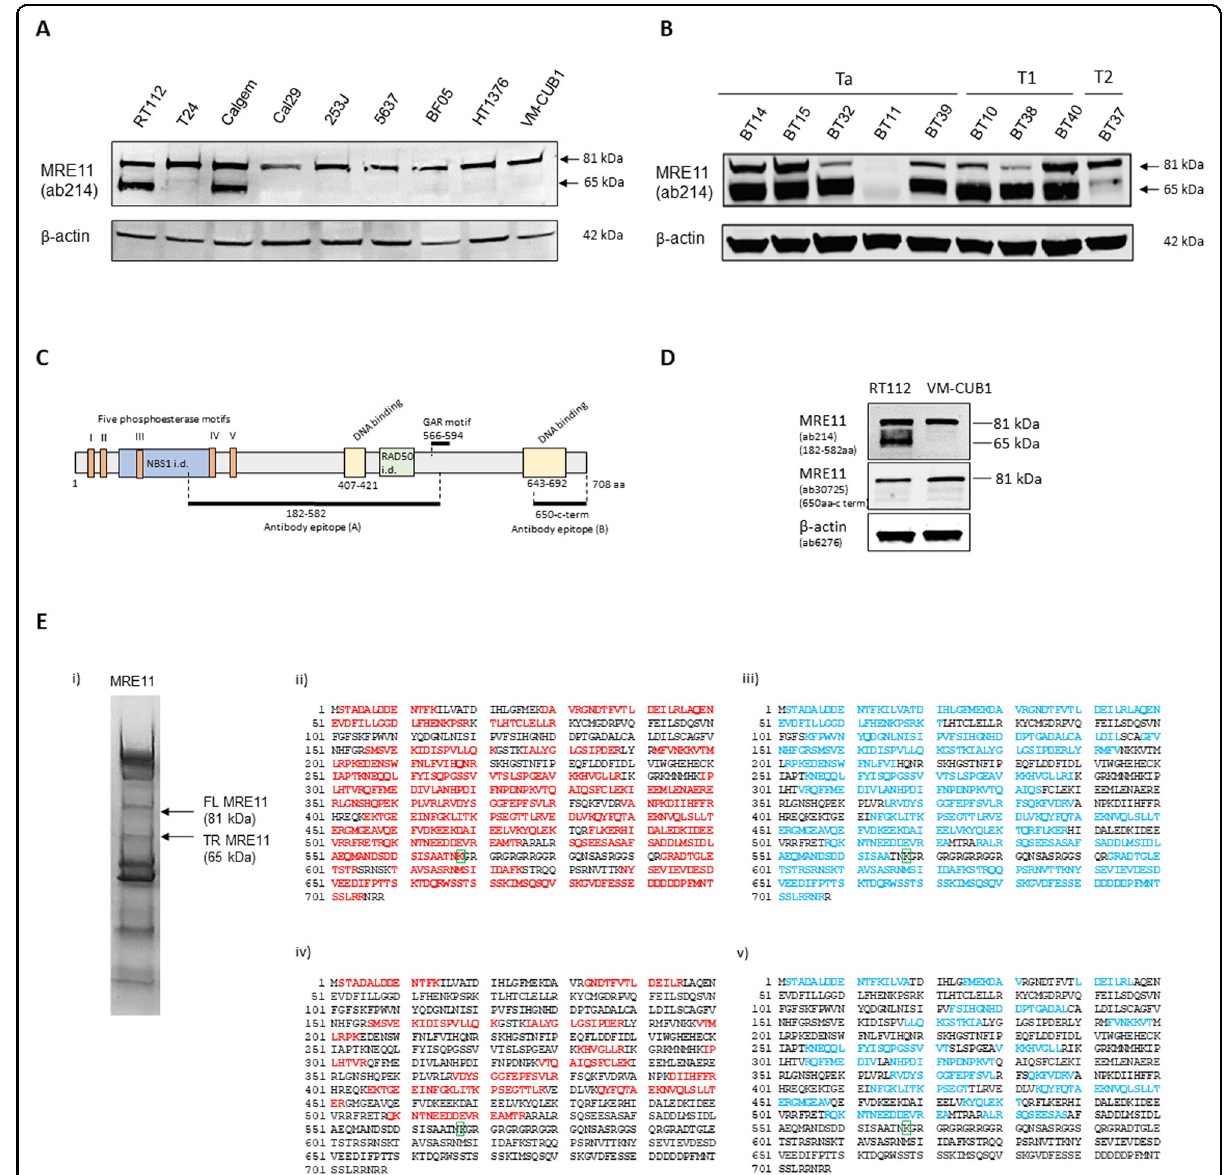
Fig. 1 MRE11 is found in truncated form in bladder cancer cell lines and primary bladder tumours. A Two out of nine bladder cancer cell lines show a truncated form of MRE11 (approximately 65 kDa). Calgem is gemcitabine-resistant cells created from Cal29 by exposure to increasing gemcitabine doses 49 . B Eight out of nine nuclear cell-free extracts from human bladder tumours show a truncated form of MRE11 (approximately 65 kDa). Ta = papillary tumour, T1 = tumour invading lamina propria, T2 = tumour invading muscularis propria. C Schematic diagram of MRE11 and the epitope regions of MRE11 of two antibodies, spanning amino from acids 182 to 582 (ab214) and 650 to C-terminus (ab30725), respectively. D In RT112, ab214, spanning amino acids 182 – 582, detected both FL and TR MRE11, but not in VM-CUB1. In contrast, the C-terminus anti-MRE11 antibody (ab30725) did not detect the truncated MRE11 both in RT112 and VM-CUB1. E -i The eluted sample from super-paramagnetic beads with recombinant protein A-bound MRE11 was loaded onto a precast 4 – 20% polyacrylamide gel. E -ii, iii The sequence coverage of FL-MRE11 digested with trypsin (red) and elastase (blue) was 71% coverage for both cases. E -iv, v Protein sequence coverage of TR-MRE11 digested with trypsin (red) and elastase (blue) were 23% and 28% respectively. The green box at K568 indicates the last amino acid of TR-MRE11